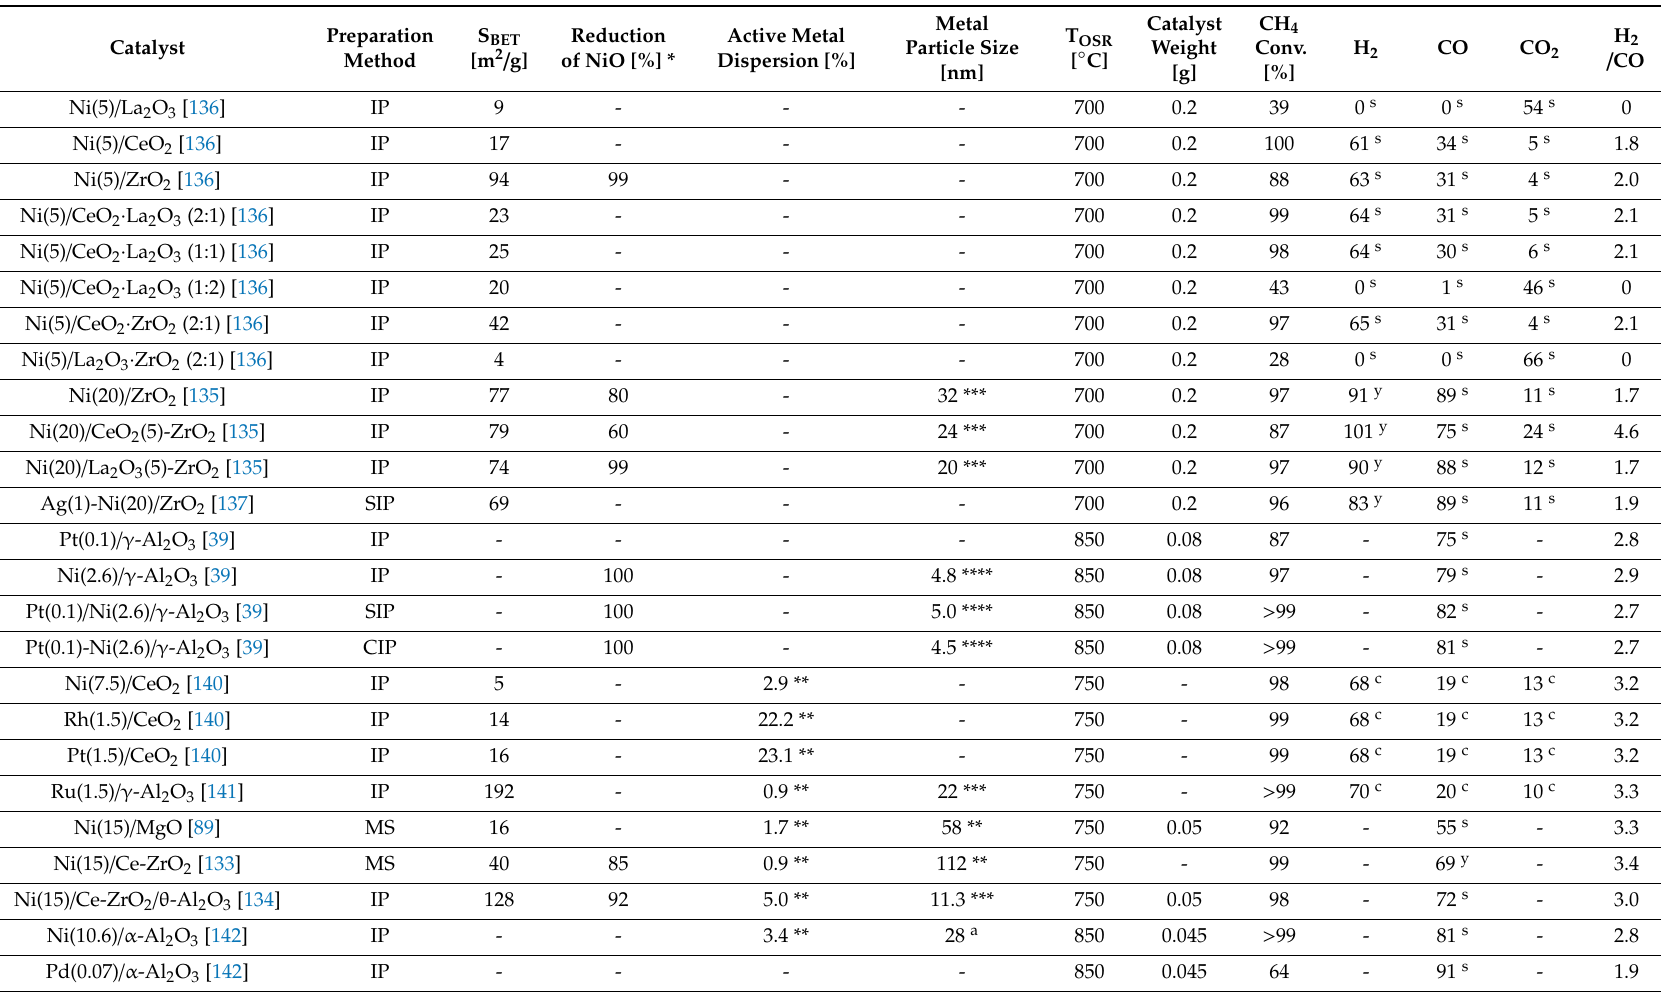
Table 3. The physicochemical and catalytic characterization of the catalytic systems applied in the OSR of the methane reaction.